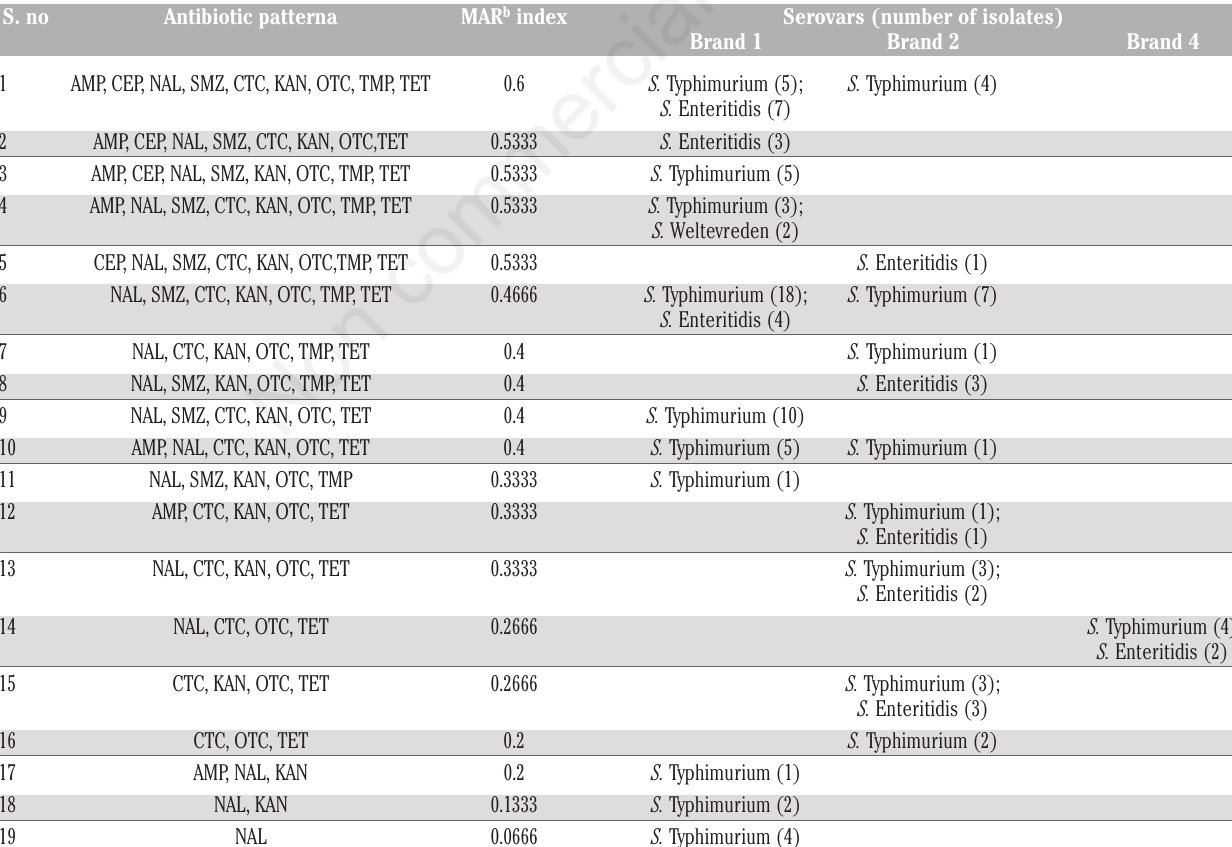
Table 2. Antibiotic resistance pattern of Salmonella spp. isolated from poultry. S.